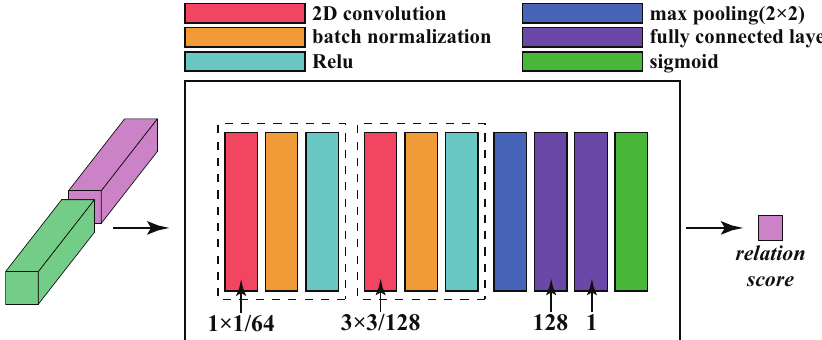
Figure 5. Visual representation of the relation learning